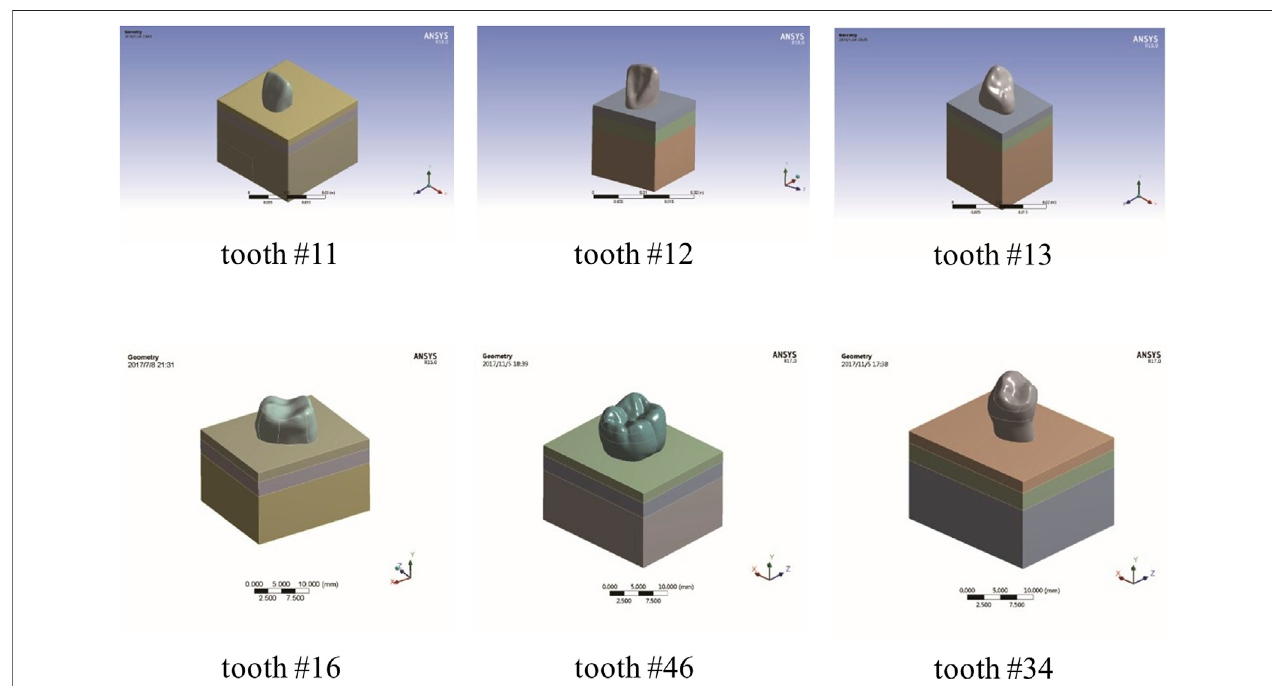
FIGURE 1 | FEA models of RAIs and surrounding tissues.